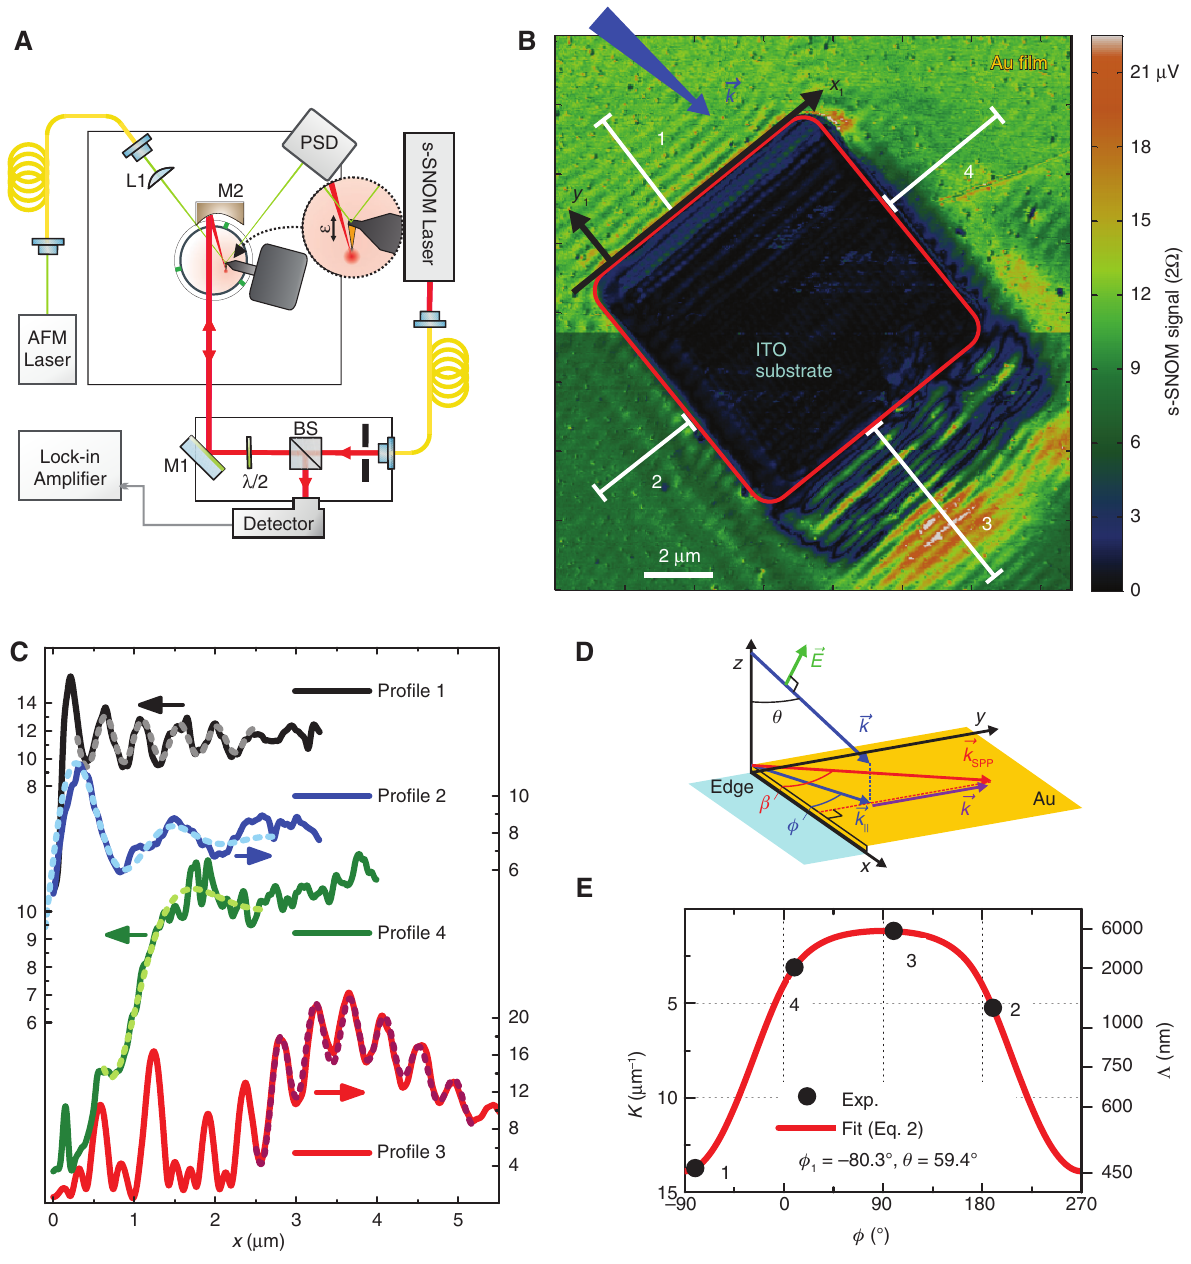
Figure 1: s-SNOM set-up and measurements at a square hole in a gold film on ITO substrate. (A) Set-up with PSD: position-sensitive detector; L1: lens for the position-sensing laser light; M2: paraboloidal mirror with a focal length of 10 mm; λ /2: half-wave plate for the control of the polarization of the light impinging onto the probe tip; BS: beam-splitter for out-coupling of the laser radiation returning from the probe tip. (B) Raster-scan image of the s-SNOM signal taken by translation of the sample under the illuminated tip, which is kept at a fixed position (signal demodulated at 2 Ω ). The red frame indicates the square hole in the gold film, with its boundaries being determined by simultaneous AFM topography recording (not shown). Also included are the x - and y -axis for region 1. The reduced signal strength in the lower part of the image is the result of a surface contamination picked up by the tip during a line scan in the middle of the scanned area. (C) s-SNOM signal profiles extracted along the white lines in B for each region 1–4 vs. distance y from their corresponding edges. The positions of the lines are chosen such that disturbances by defects on the surface are avoided. Note that the spatial decay lengths of the signal modulation do not represent that of the SPPs alone, as they are excited by the incoming beam that stays fixed to the tip while the sample is scanned. The dotted fit curves yield the oscillation periods mentioned in the text. (D) Schematic wave (cid:31) (cid:31) k denote the wave vectors of the incoming beam and the SPP launched at the vectors and angles appearing in Eqs. (1) and (2). k and (cid:30) (cid:30)(cid:30) SPP K k k denotes the expected wave vector of the observed s-SNOM interference signals. (E) Wavelengths Λ of edge, respectively, while = − (cid:31) SPP the SPP interference fringes vs. respective azimuthal angle φ and model curve using Eq.